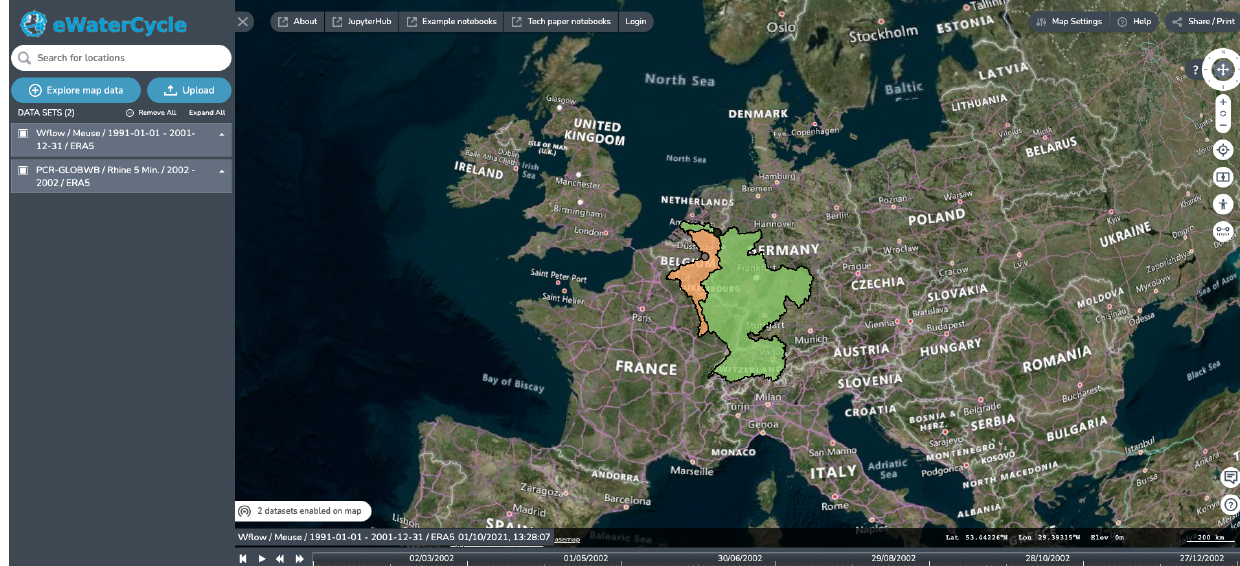
Figure 3. Screenshots of the explorer, which allows users to explore and select models available based on regions for which they are available (i.e., suitable forcing and parameter sets are available). Background maps are © Microsoft Bing Maps 2018 screenshot(s) reprinted with permission from the Microsoft